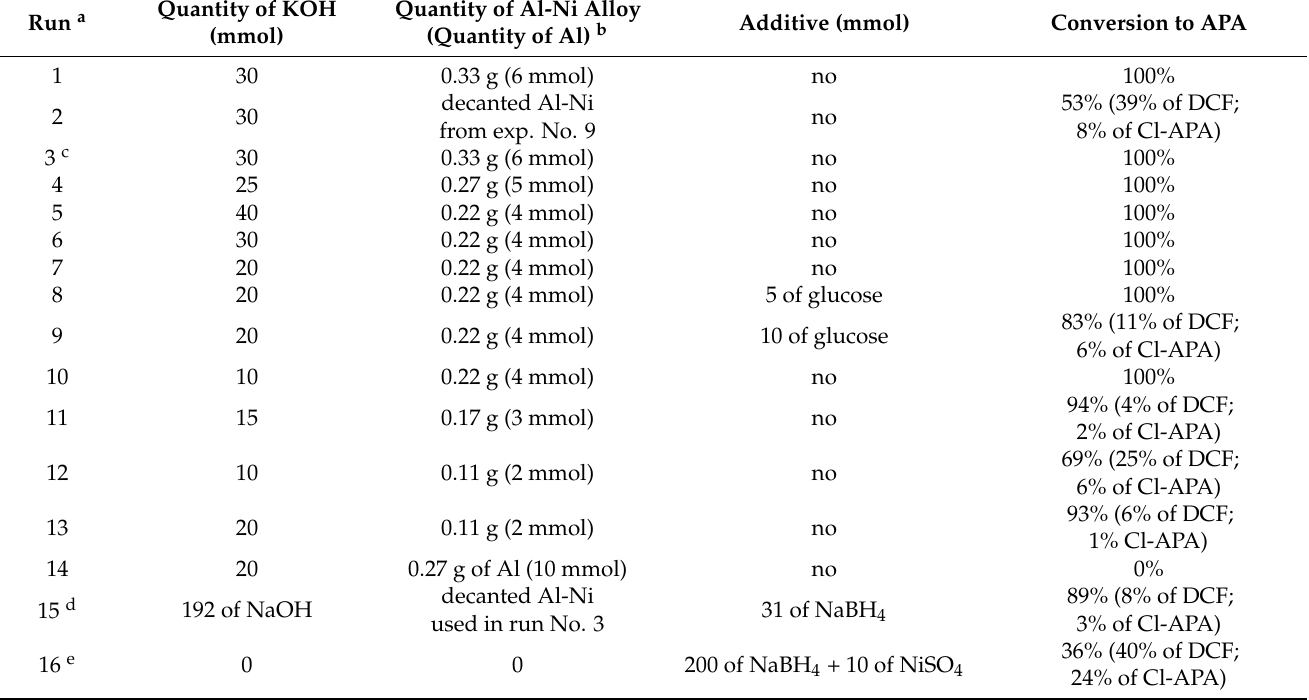
Table 2. HDC efficiencies of DCF using a different quantity and type of